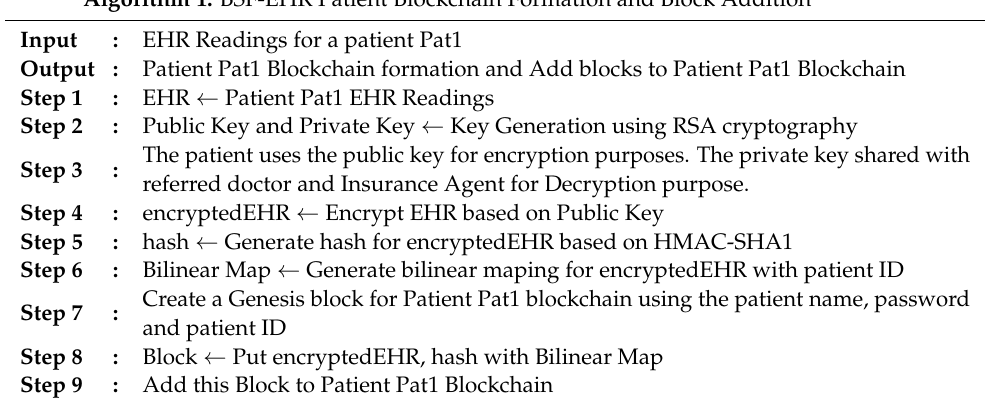
Algorithm 1. BSF-EHR Patient Blockchain Formation and Block